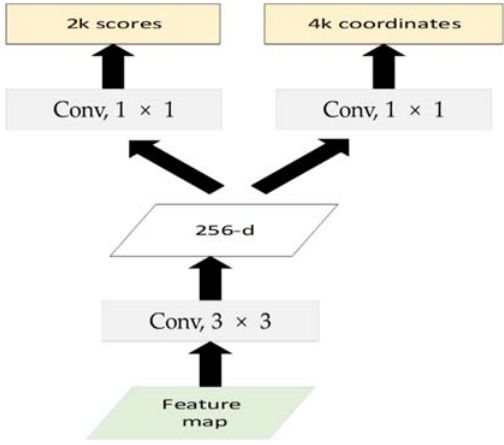
Figure 11. Illustration of the RPN network. Feature maps extracted by the feature extraction module were first processed with a 3 × 3 convolution to generate a 256-dimension feature map, then two branches of 1 × 1 convolution were used to obtain 2 × k foreground and background scores and 4 × k coordinates separately; finally, candidate boxes were generated by scores and coordinates.